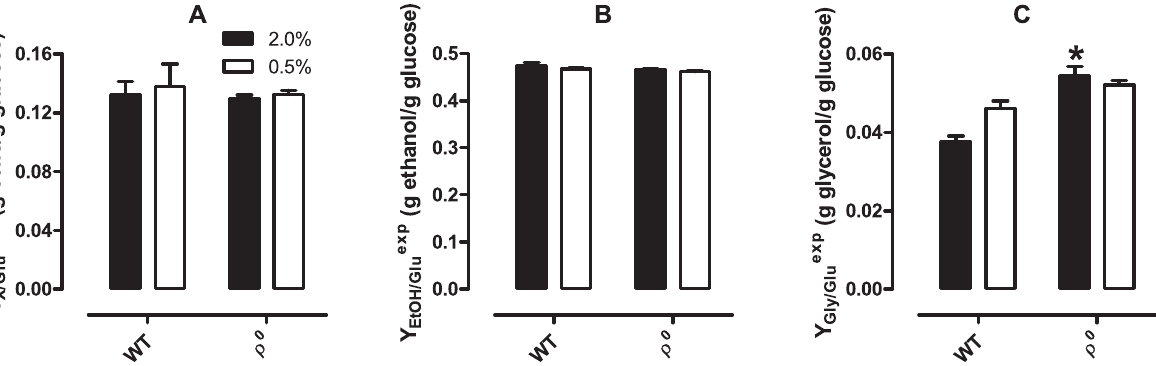
Figure 7. Glucose-to-biomass, glucose-to-ethanol and glucose-to-glycerol conversion factors. Glucose-to-biomass (Y X/Gluexp , Panel A), glucose-to-ethanol (Y EtOH/Gluexp , Panel B) and glucose-to-glycerol (Y Gly/Gluexp , Panel C) conversion factors in WT and r 0 S. cerevisiae were calculated as described in Materials and Methods . * p , 0.05 vs. WT (unpaired Student’s t test).